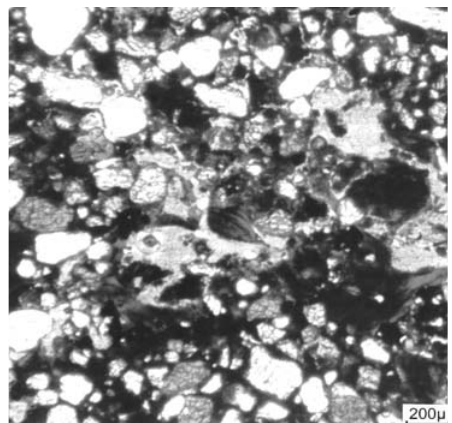
Figura 7. Macroporosidade formada por cavidades e fissuras e zonas porfirogrânicas e, ou, porfirogefúricas contínuas no horizonte Bt do perfil